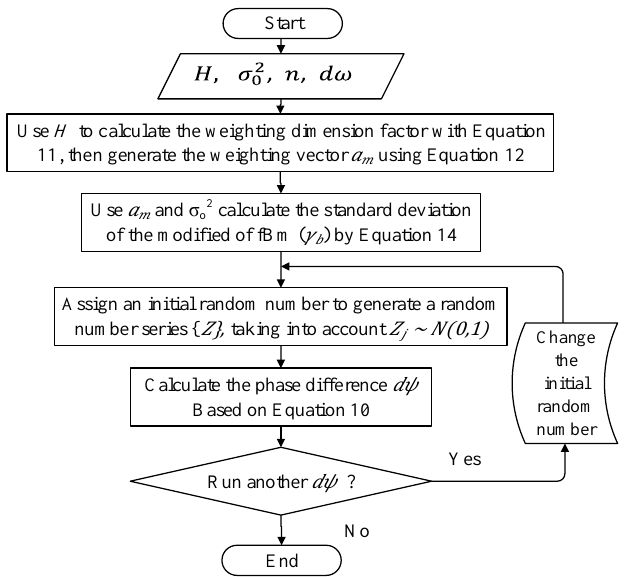
Figure 3. Flowchart of the phase difference